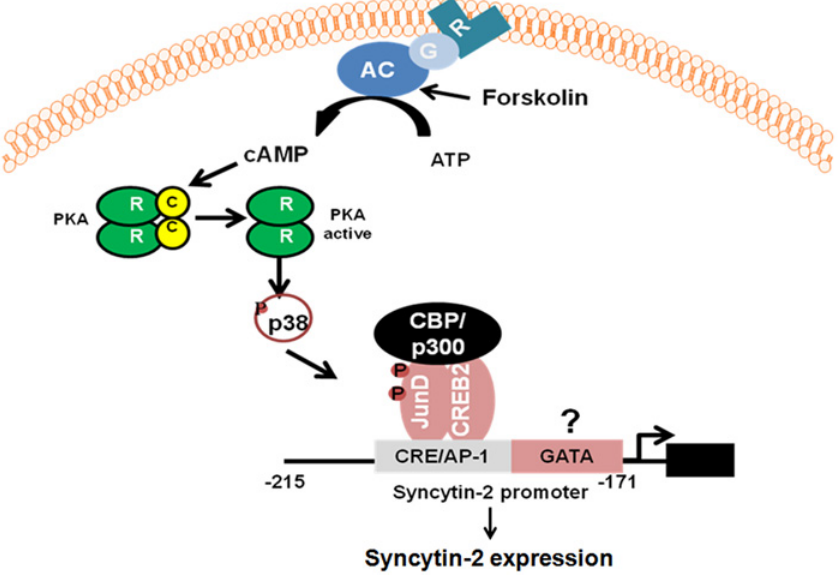
Fig 9. Proposed model for CREB2/JunD-mediated activation of Syncytin-2 expression. Based on the experiments shown in this study, we propose that p38MAPK activation upon forskolin stimulation activates